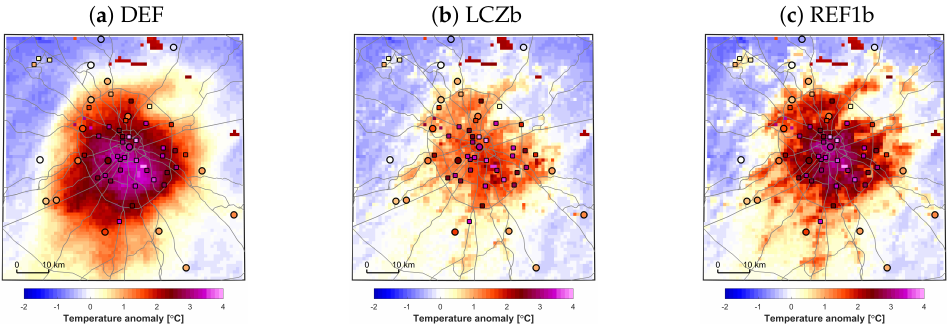
Figure 13. Spatial distribution of the daily-mean UHI intensity (temperature anomaly), averaged over the sub-periods in January 2017, according to observations at WSs (circle markers), AAQS (square markers) and model results for DEF ( a ), LCZb ( b ), and REF1b ( c ) model simulations.